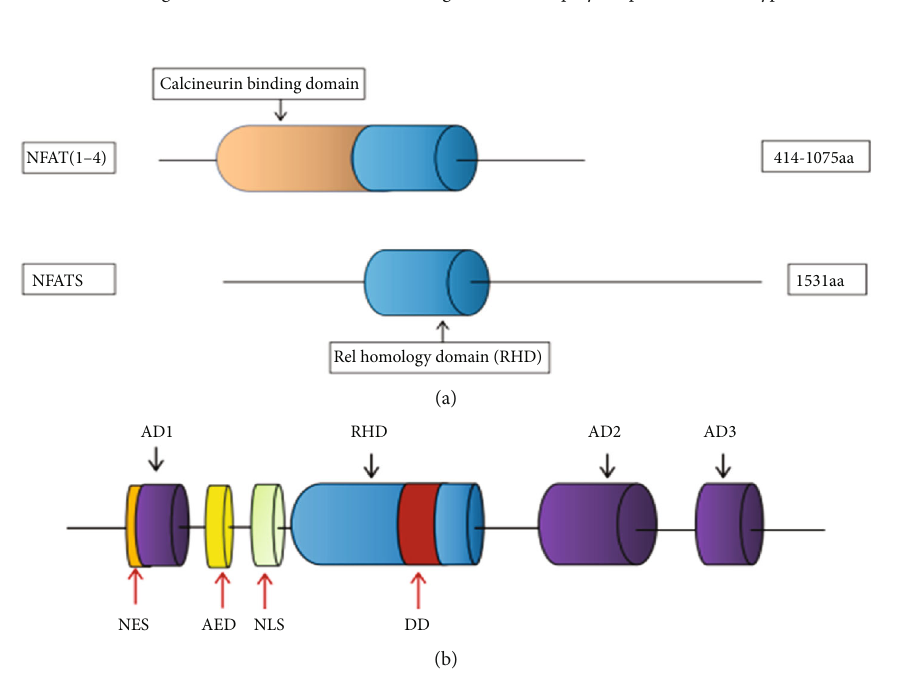
Figure 1: Structure of nuclear factor of activated T cells 5 (NFAT) family members. (a) Comparison of structures of NFAT5 and NFAT1-4. Rel homology domain (RHD) exists in NFAT1-5. NFAT5 lacks a calcineurin-binding domain. (b) Speci fi c composition of NFAT5: three transactivation domains (AD): AD1, AD2, and AD3; nuclear export sequence (NES); auxiliary export domain (AED); nuclear localization signal (NLS); dimerization domain (DD).